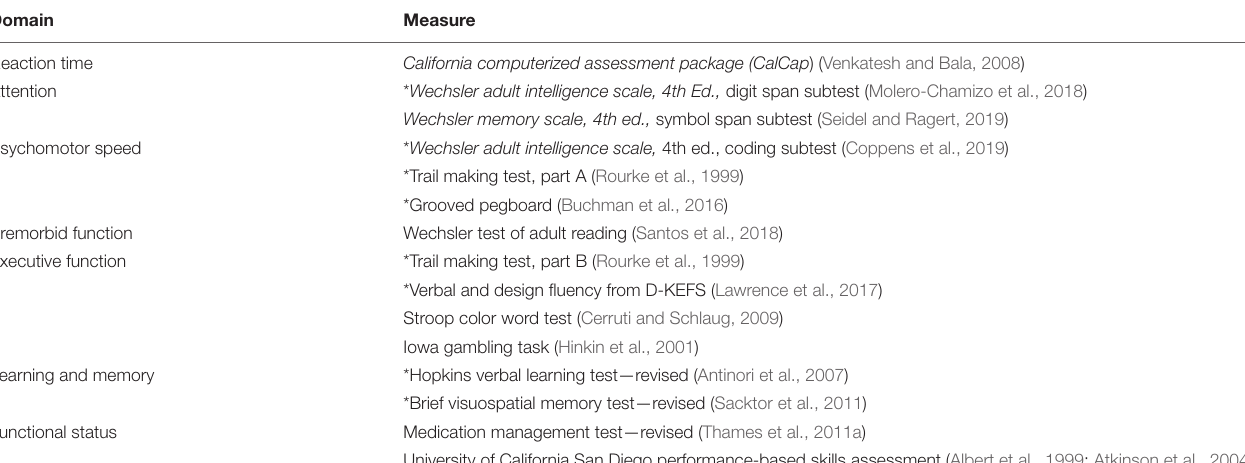
TABLE 1 | Cognitive and functional measures